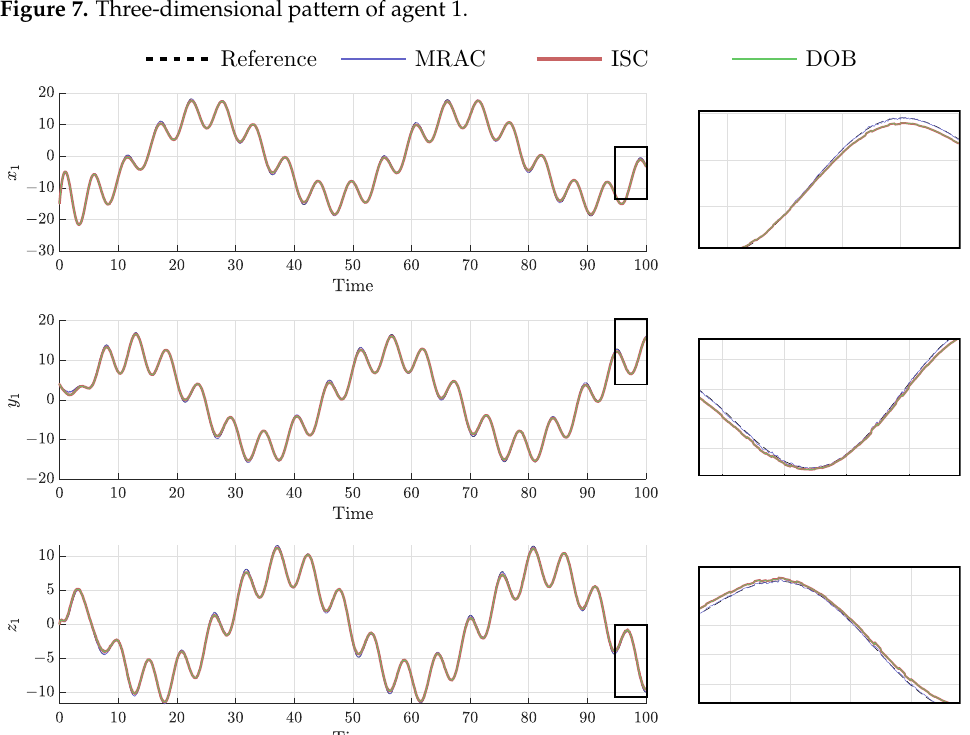
Figure 8. Spatial component of agent 1’s